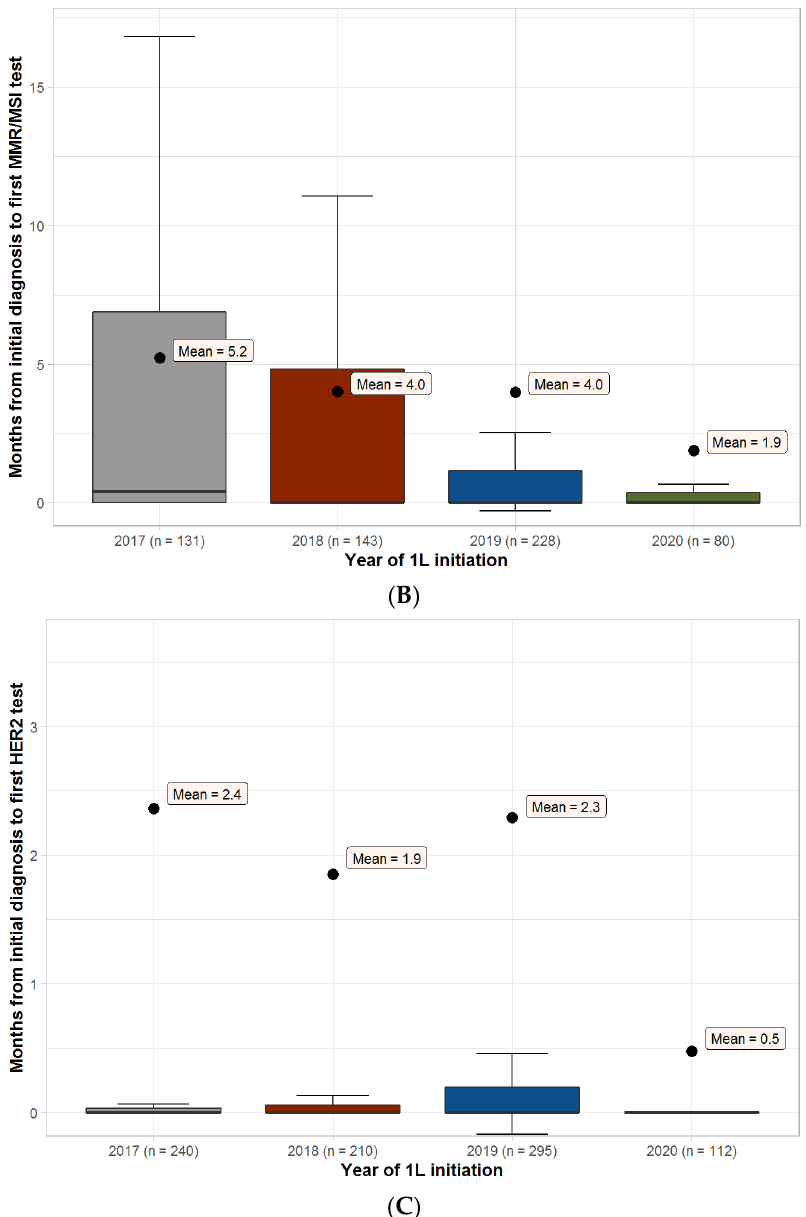
Figure 2 . Months from initial diagnosis of gastroesophageal cancer to first biomarker test. Boxplots of time (months) from initial diagnosis of gastroesophageal cancer to first biomarker test. Boxes represent the interquartile range (IQR), and the thick horizontal line represents the median (this value is 0 for years 2018 – 2020 for all biomarkers). The upper whisker represents (Q3 + 1.5xIQR), and the lower whisker represents (Q1 − 1.5×IQR). The outliers are not shown on the graph. 1L, first-line. HER2, human epidermal growth factor receptor 2. MSI, microsatellite instability. MMR, mismatch repair. n, number of patients. PD-L1, programmed cell death-ligand 1. ( A ) PD-L1; ( B ) MMR/MSI; ( C ) HER2 .